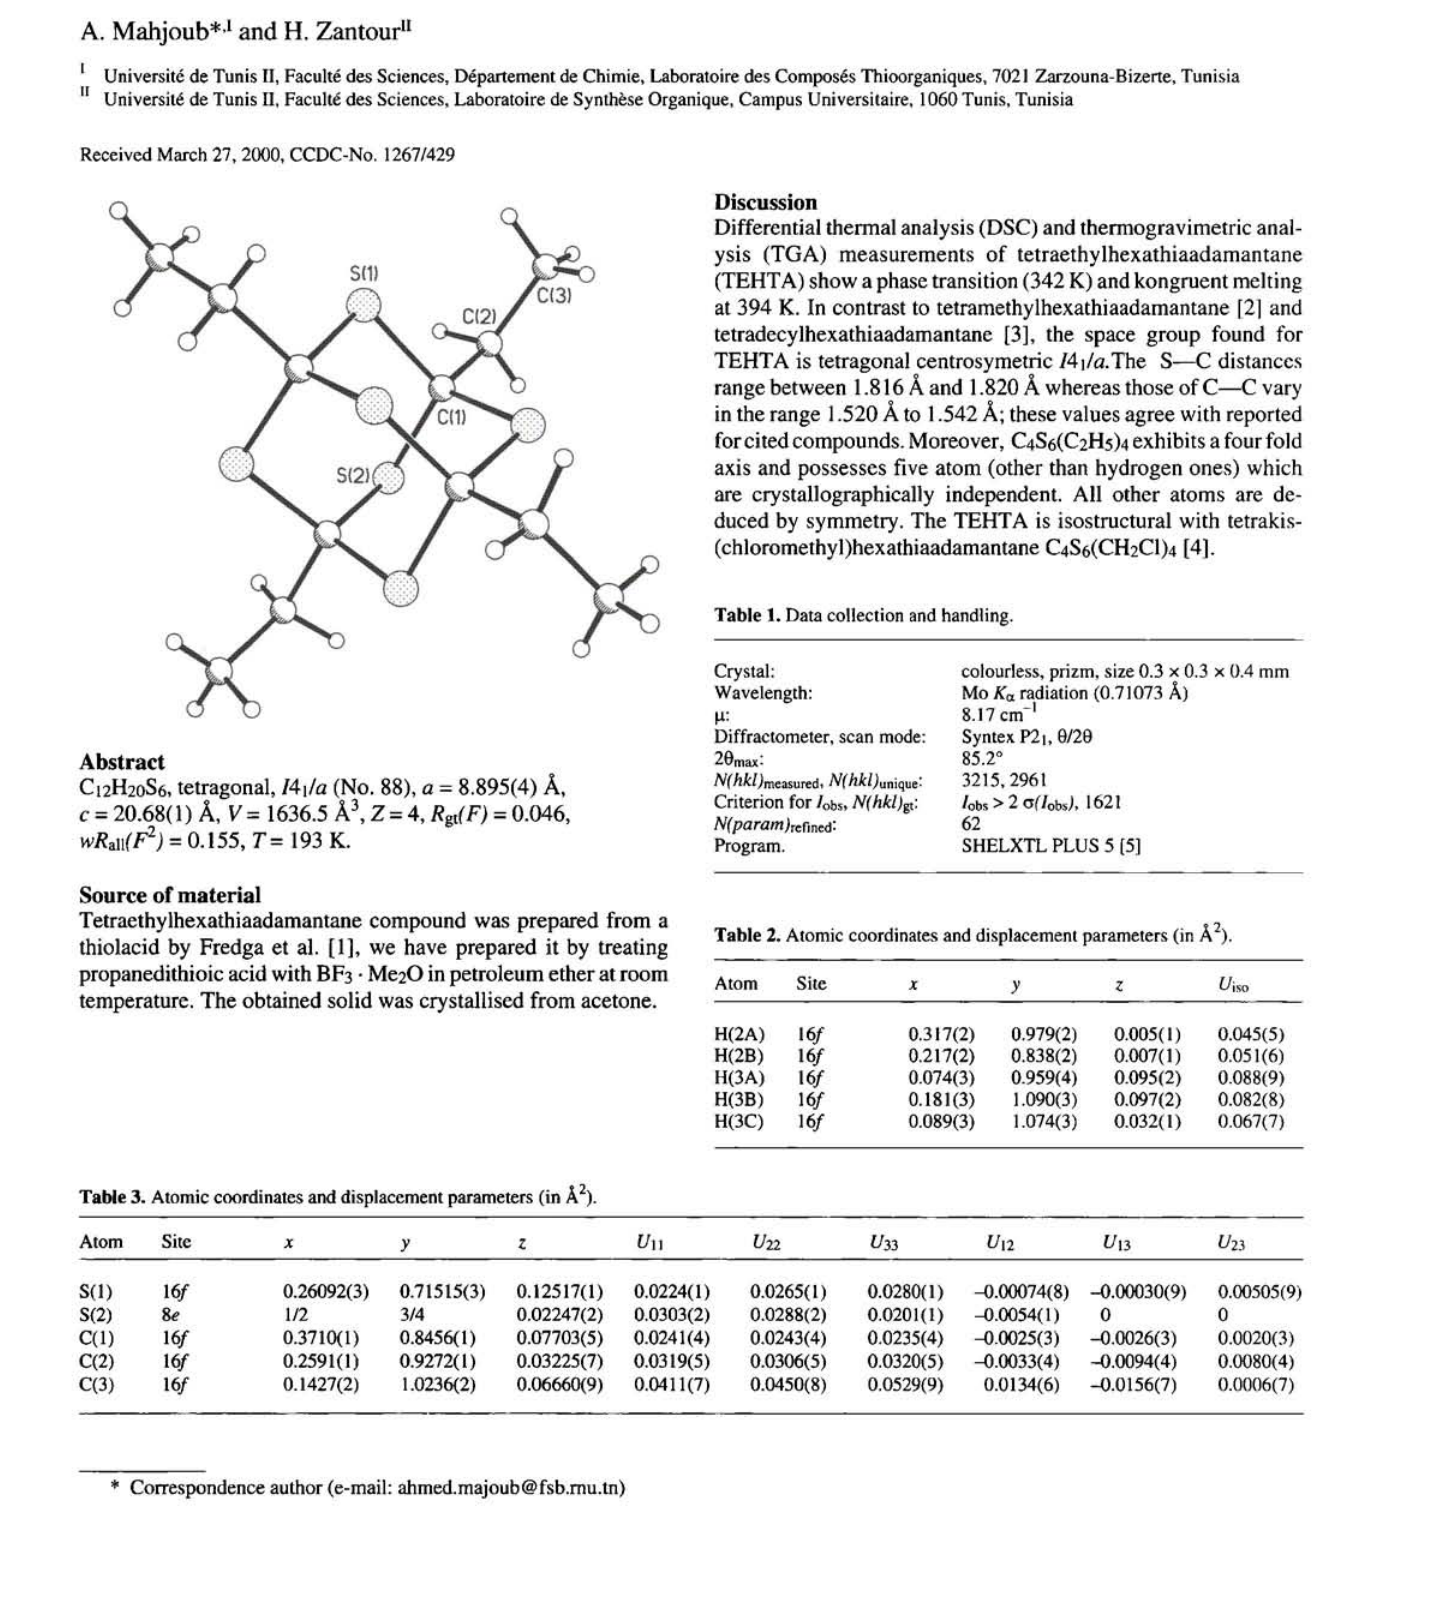
Table 3. Atomic coordinates and displacement parameters (in Â 2